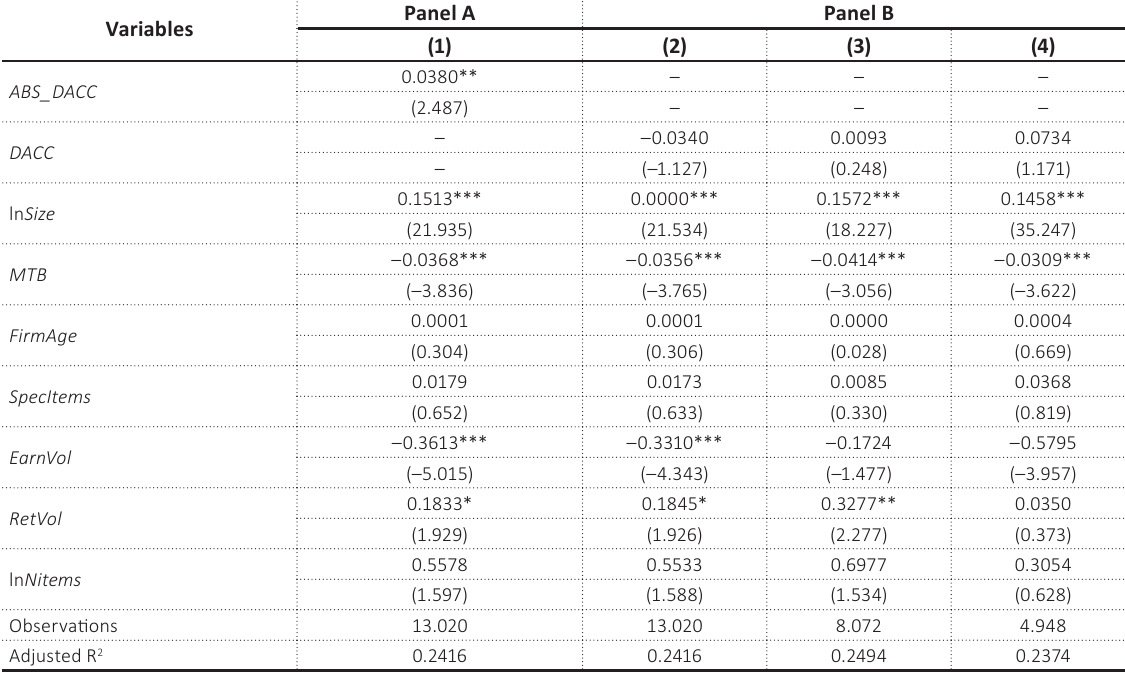
Table 2. Relationship between earnings management and impression